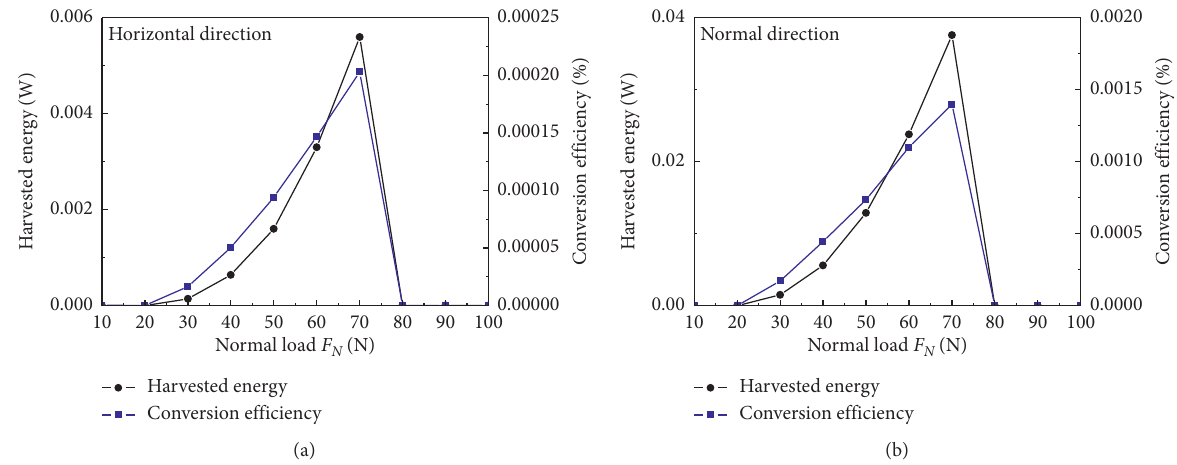
Figure 24: Considering separation, the harvested energy and conversion efficiency of the friction system in the horizontal direction (a) and normal direction (b) with different normal